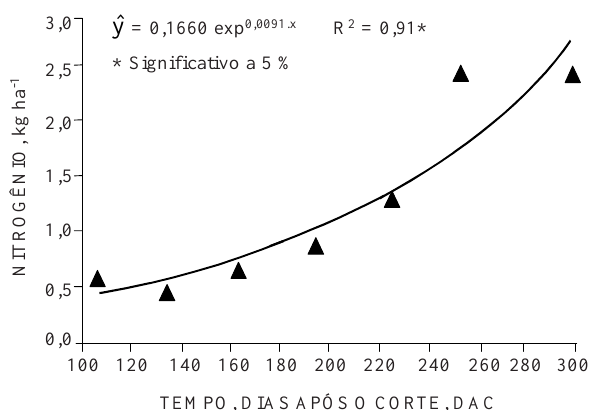
Figura 1. Nitrogênio mineralizado da palhada e recuperado na parte aérea da cana-de-açúcar de acordo com o